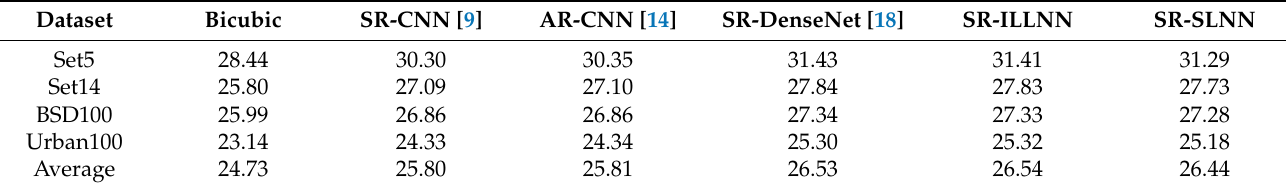
Table 6. Average results of PSNR (dB) on the test dataset.